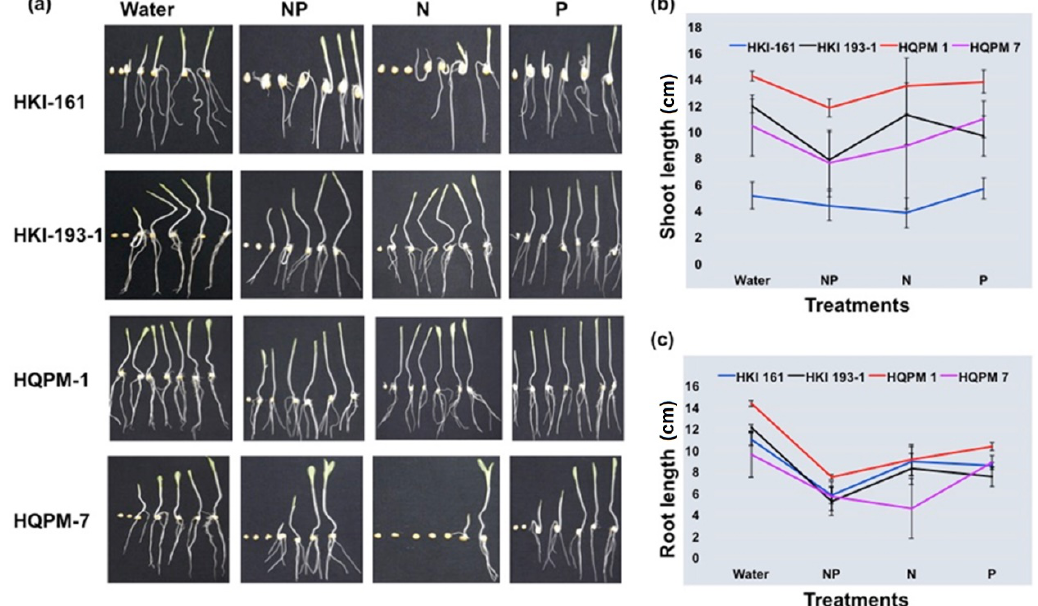
Figure 1. ( a ) Representative pictures showing the effect of exogenously added nutrients on maize seed germination in four maize genotypes. Average values of ( b ) shoot and ( c ) root length recorded for the seeds germinated in presence of water (control), nitrogen (N), phosphorous (P) and both NP are plotted. Bars represent the standard error of the mean among the three biological replicates.